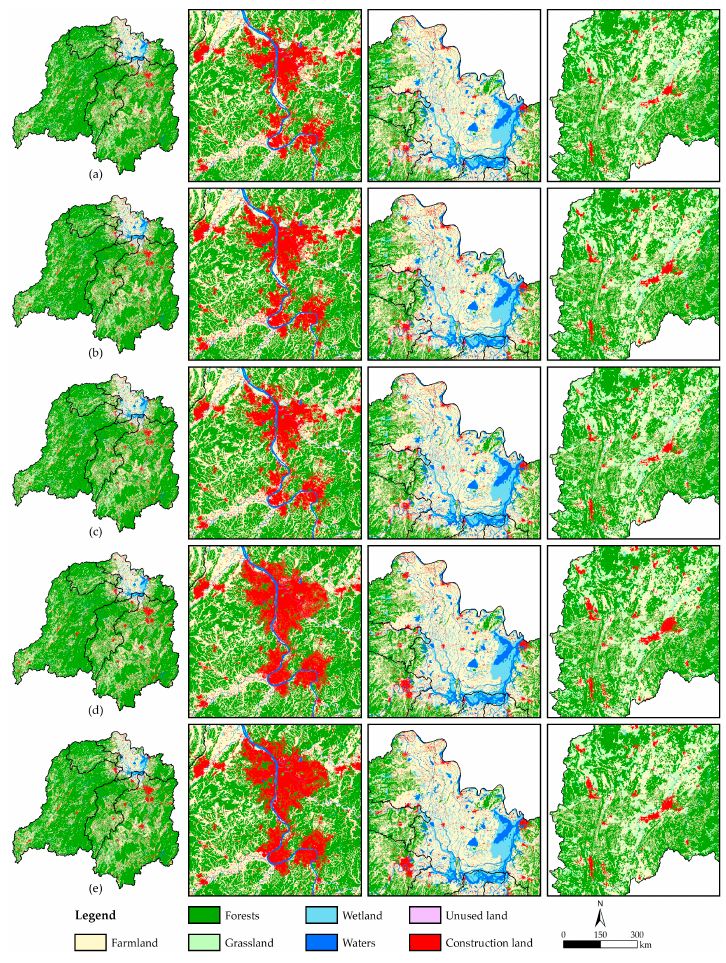
Figure 3. Spatial distribution of land-use types in DLB from 2020 to 2030. ( a – e ) In 2020/2030NES/2030EPS/2030EDS/2030PDS. By visualizing the transition among various land-use types with the transformed area larger than 1 km 2 (Figure 4), the transition of farmland and grassland to construction land will be the main land circulation direction; the circum–Changsha–Zhuzhou–Xiangtan ur- ban agglomeration and the southeast of Guizhou Province are predicted to be areas with the most intense land-use changes, and the urban development areas characterized by the presence of construction land will show different expansion trends (Figure 3).